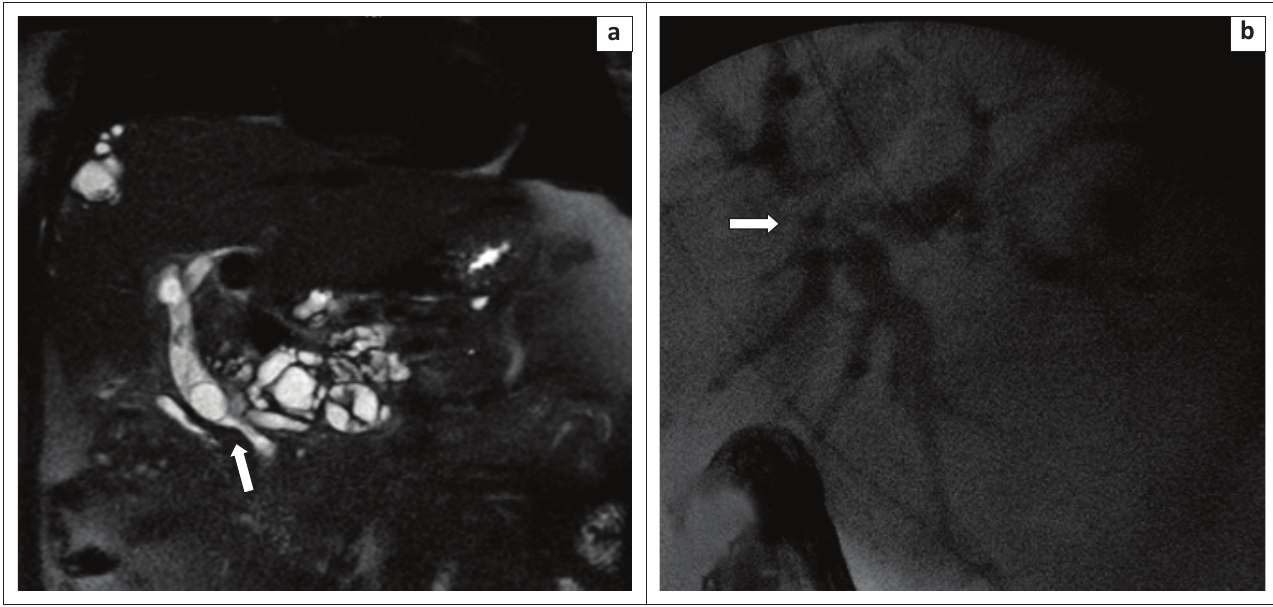
FIGURE 4: Seventy-four-year-old woman with hydatid cyst and daughter vesicles: (a) The daughter cyst (arrow) inside the common bile duct is shown by MRCP; (b) irregular dilatations and compression of the biliary system owing to hydatid cysts (arrow) are seen by